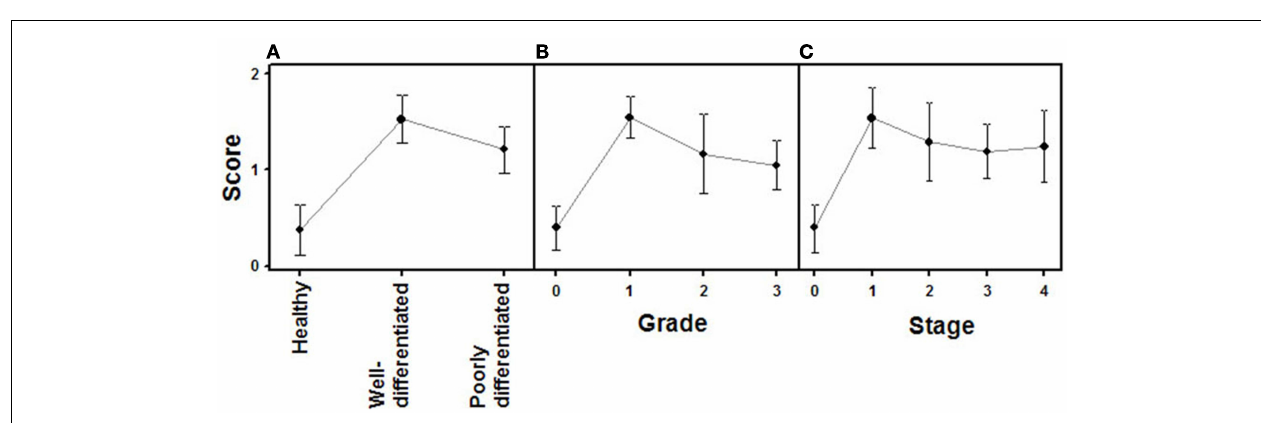
FIGURE 3 | Immunohistochemical staining of syndecan 2 in NETs . (A,D,G,J) Normal tissue from colon (A) , lung (D) , small intestine (G) , and gastric transitional mucosa (J) . (B,E,H,K) Well-differentiated NETs from colon (B) , lung (E) , small intestine (H) , and pancreas (K) . (C,F,I,L) Poorly differentiated NETs from colon (C) , lung (F) , stomach (I) ,